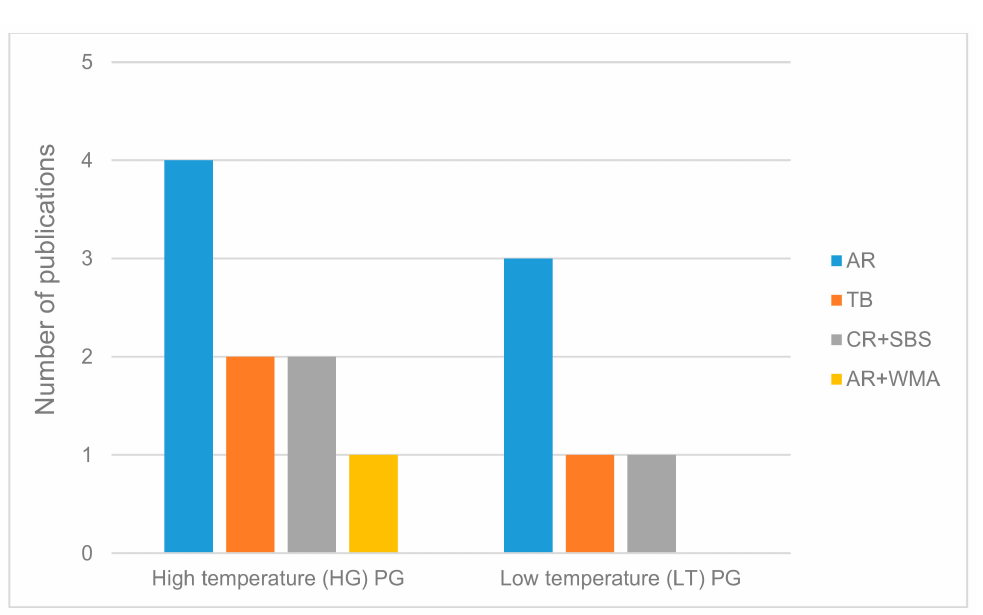
Figure 10. Number of publications where the results report a higher value of the analyzed characteristic of CRM binders (AR, TB, CR + SBS and AR + WMA) compared to the traditional